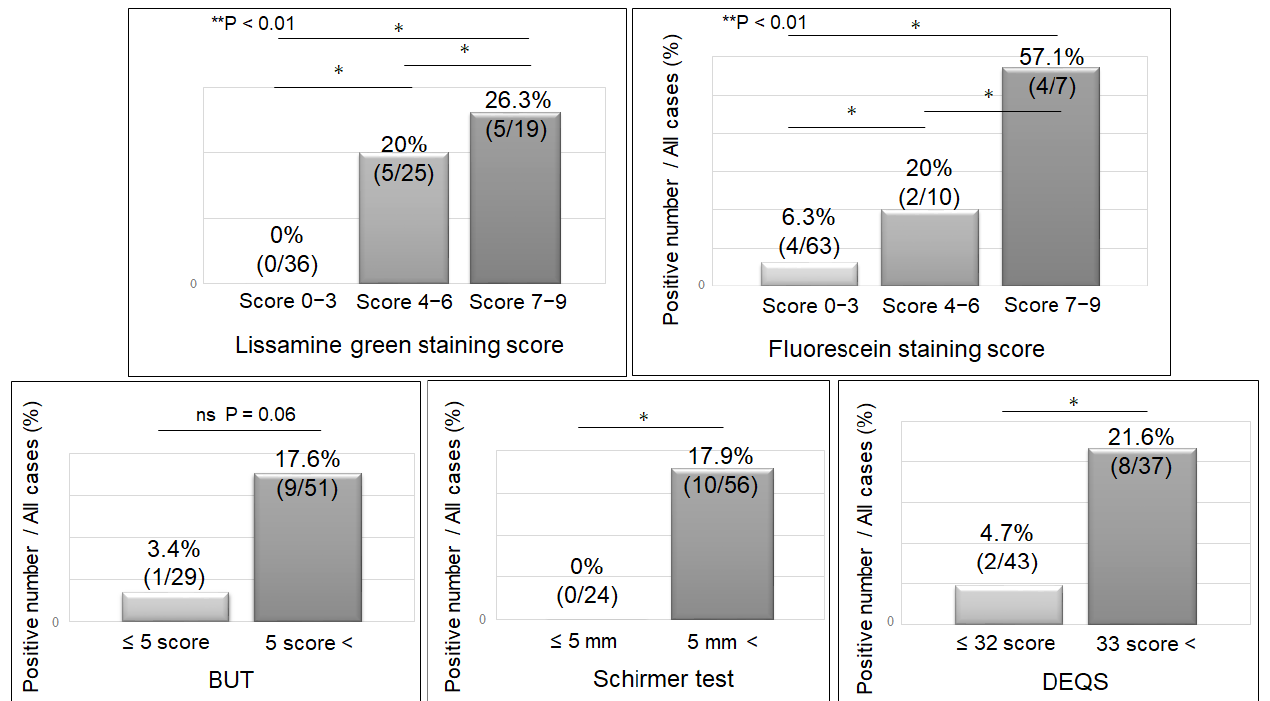
Figure 4. The detection rate of gal-3C in patients and controls. Gal-3C was detected in 19.2% of patients with dry eye disease, and not detected in controls ( p < 0.01) ** p < 0.01; gal-3C, cleaved galectin-3.